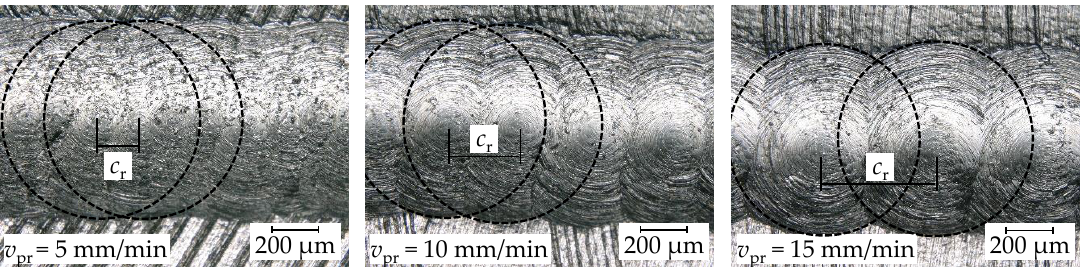
Figure 7. Track geometry resulting for various process velocities (tool diameter r pr = 3 mm, spindle speed S = 20 min −1 ).